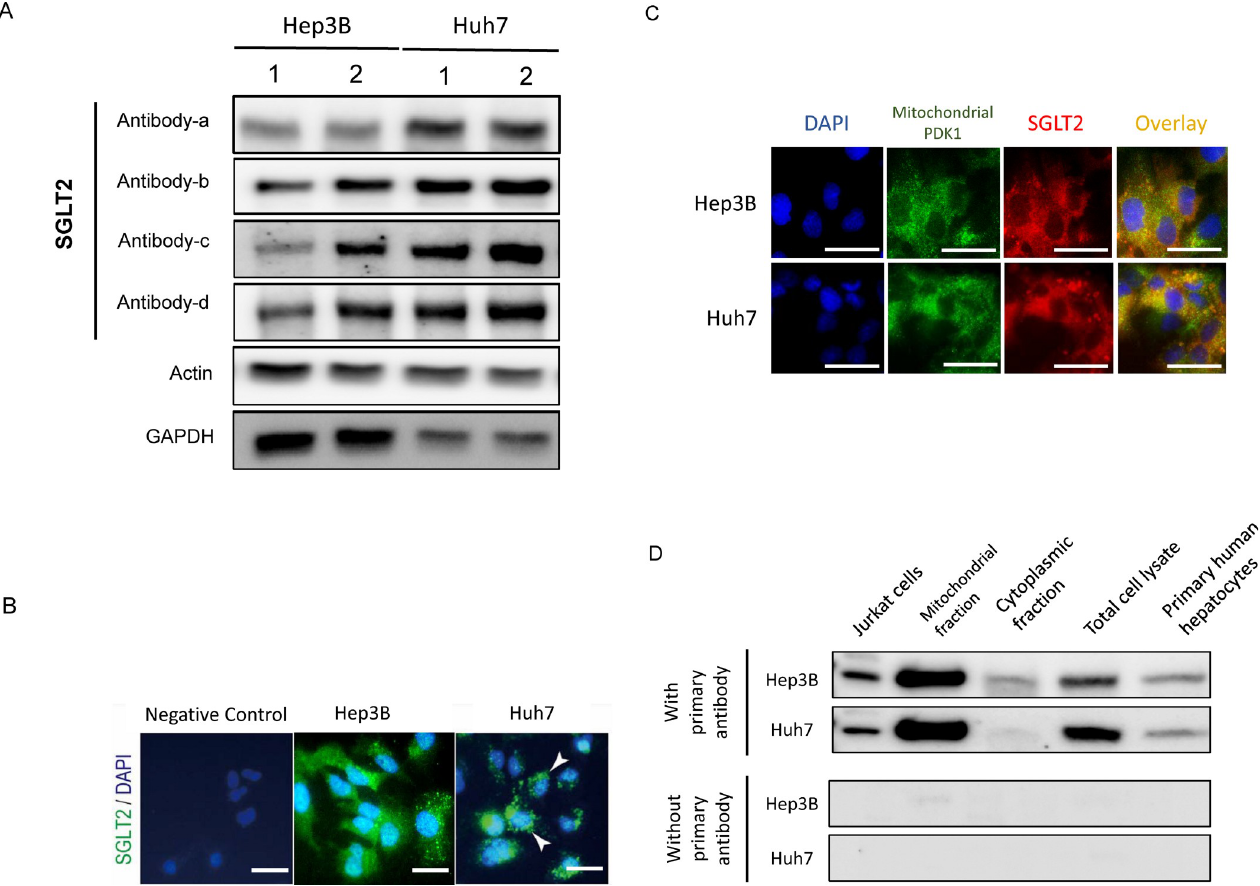
Fig 1. Expression of SGLT2 in Hep3B and Huh7. A) Immunoblotting using 4 different antibodies for SGLT2: Antibody-a, Proteintech Group, Inc. (24654- 1-AP); Antibody-b, Abcam plc. (ab137207); Antibody-c, Abcam plc. (ab85626), Antibody-d, Cell Signaling Technology, Inc. (#14210). B) Immunohistochemistry for SGLT2. Green indicates SGLT2. The nucleus was stained by DAPI. Scale bar = 50 μ m. C) Double immunostaining for mitochondrial PDK-1 and SGLT2. Green indicates mitochondrial PDK-1. Red indicates SGLT2. Yellow indicates colocalization of mitochondrial PDK-1 and SGLT2. The nucleus was stained by DAPI. Scale bar = 50 μ m. D) Immunoblotting for SGLT2 in mitochondrial and cytoplasmic fractions. Abbreviations: SGLT2, sodium-glucose cotransporter 2; GAPDH, glyceraldehyde-3-phosphate dehydrogenase; DAPI, 4’,6-diamidino-2-phenylindole; PDK-1, pyruvate dehydrogenase kinase